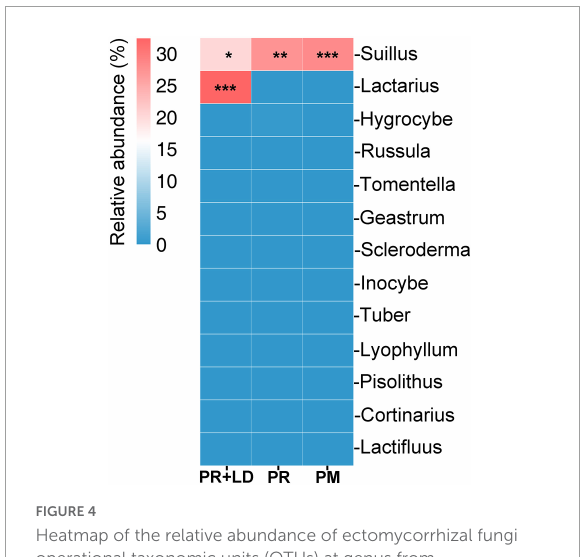
FIGURE4 Heatmap of the relative abundance of ectomycorrhizal fungi operational taxonomic units (OTUs) at genus from mycorrhizosphere and rhizosphere soil of Pinus radiata + Lactarius deliciosus (PR + LD), PR and Pinus massoniana (PM) (agglomerated to genus). * P < 0.05; ** P < 0.01; *** P <